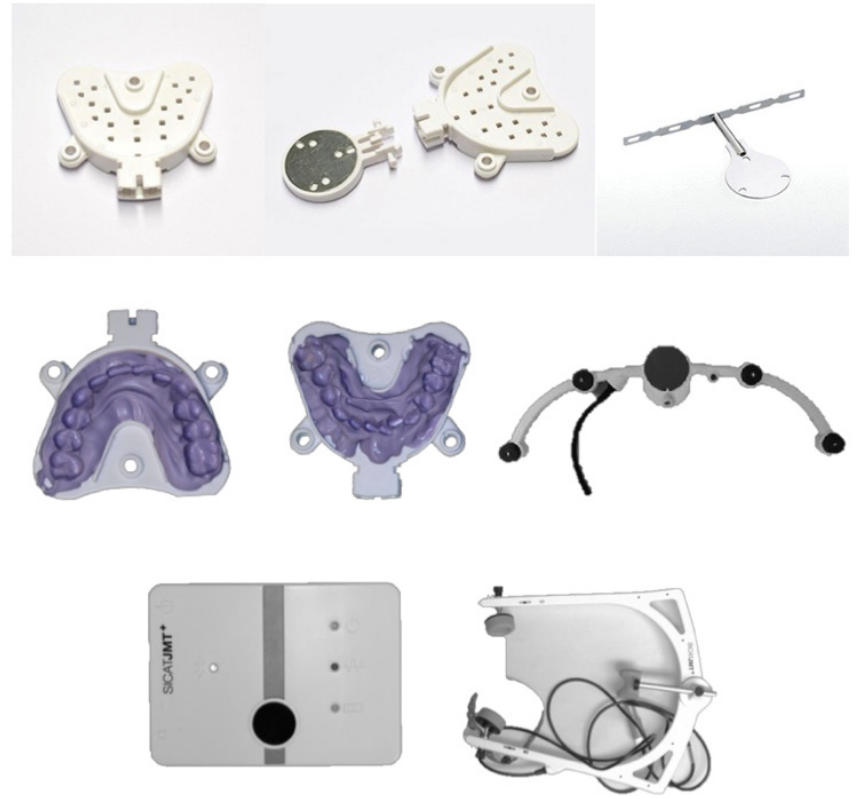
Figure 2. T-attachment, Fusion Bite Tray, lower jaw sensor, facebow with nasion support, neckband, and headband.